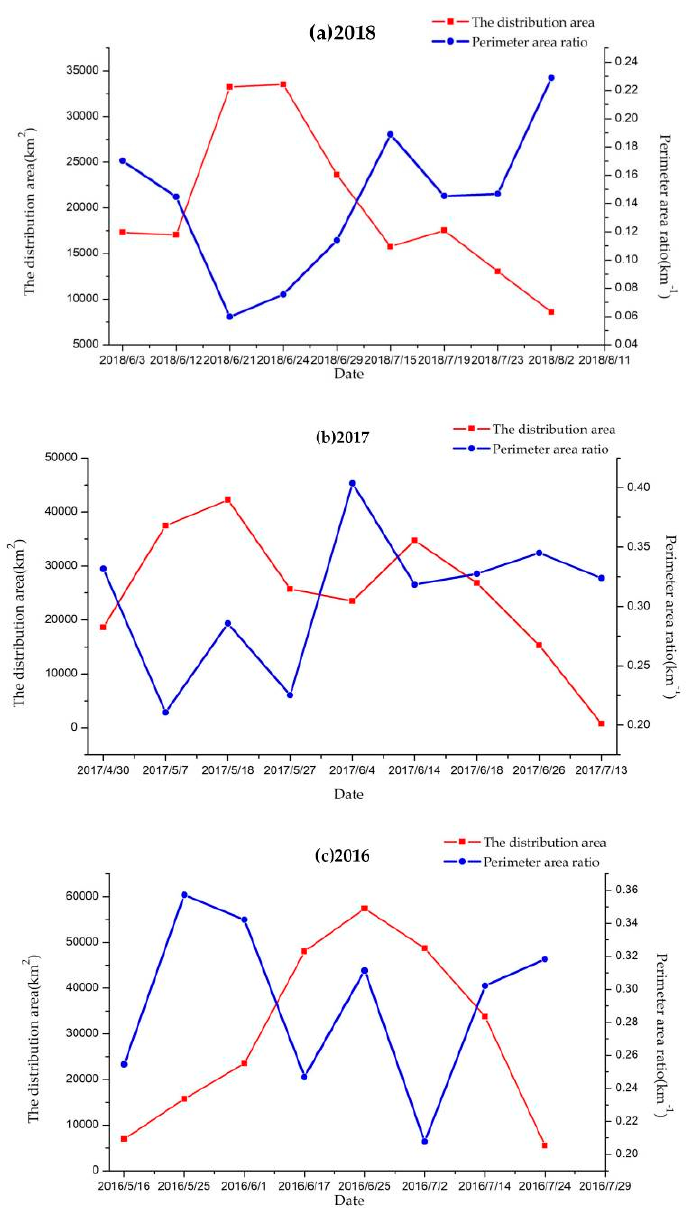
Figure 13. ( a ) Distribution area and perimeter ratio in 2018 are shown in the diagram as two broken lines. The transverse coordinates represent the time series. The left vertical coordinate is the distribution area, and the right vertical coordinate is the ratio of the perimeter to area. ( b ) Distribution area and perimeter ratio in 2017. ( c ) Distribution area and perimeter ratio in 2016.